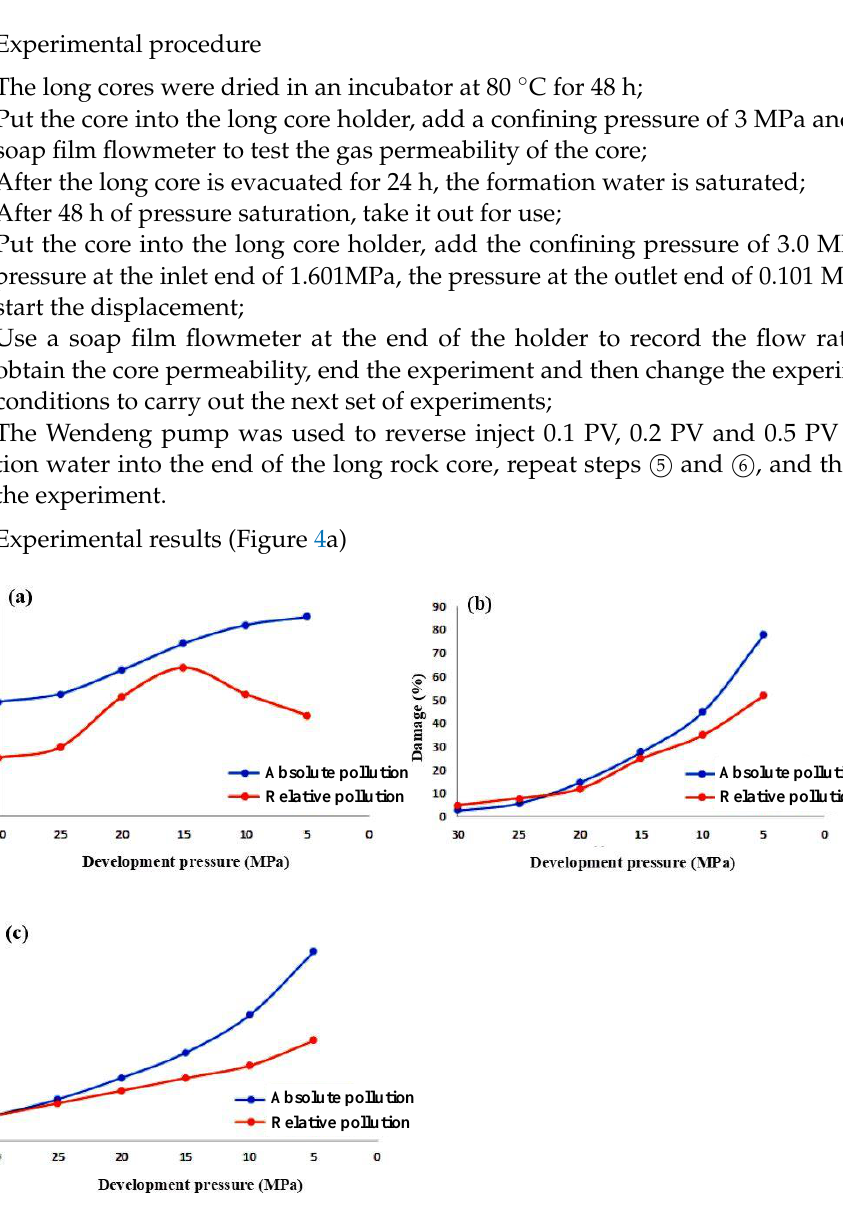
Figure 4. Variation curves. ( a ) Variation curve of water solvent pollution from fracturing water degree with formation pressure drop. ( b ) Variation curve of stress-sensitive pollution degree with drop of formation pressure. ( c ) Variation curve of pollution degree of threshold pressure gradient with drop of formation pressure.